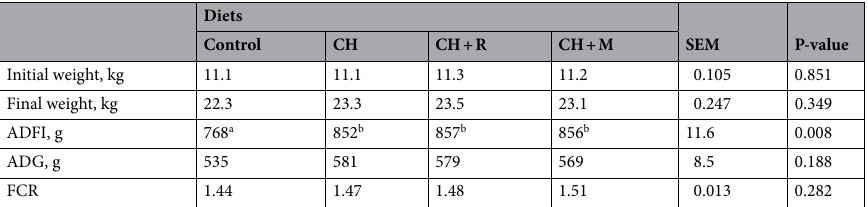
Table 1. Effect of diets on feed intake and growth performance of piglets. Control = control diet; CH = Chlorella vulgaris diet; CH + R = C. vulgaris diet supplemented with Rovabio® Excel AP; CH + M = C. vulgaris diet supplemented with a pre-selected enzymatic mixture. ADFI average daily feed intake, ADG average daily gain, FCR feed conversion ratio. a,b Values within a row with different superscripts differ significantly at P < 0.05.